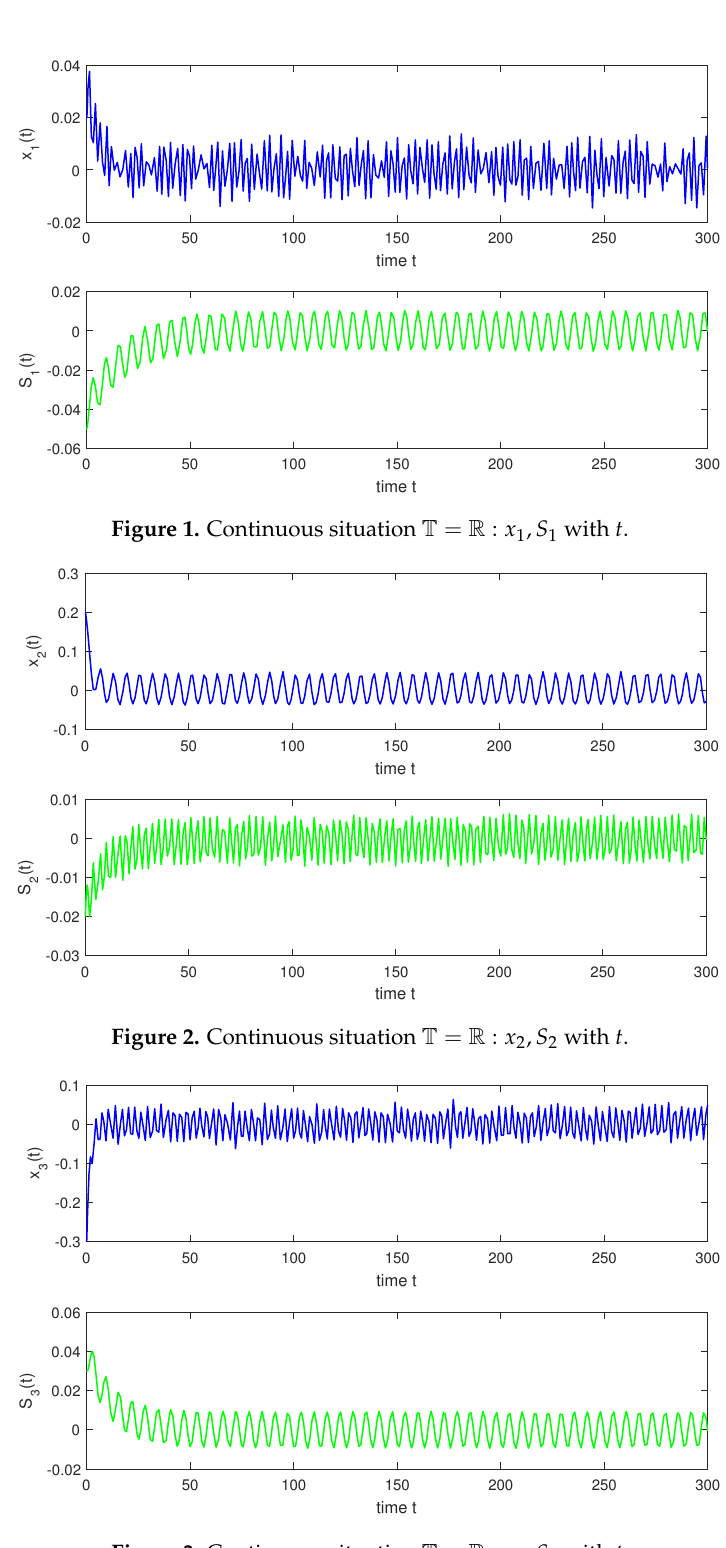
Figure 3. Continuous situation T = R : x 3 , S 3 with t